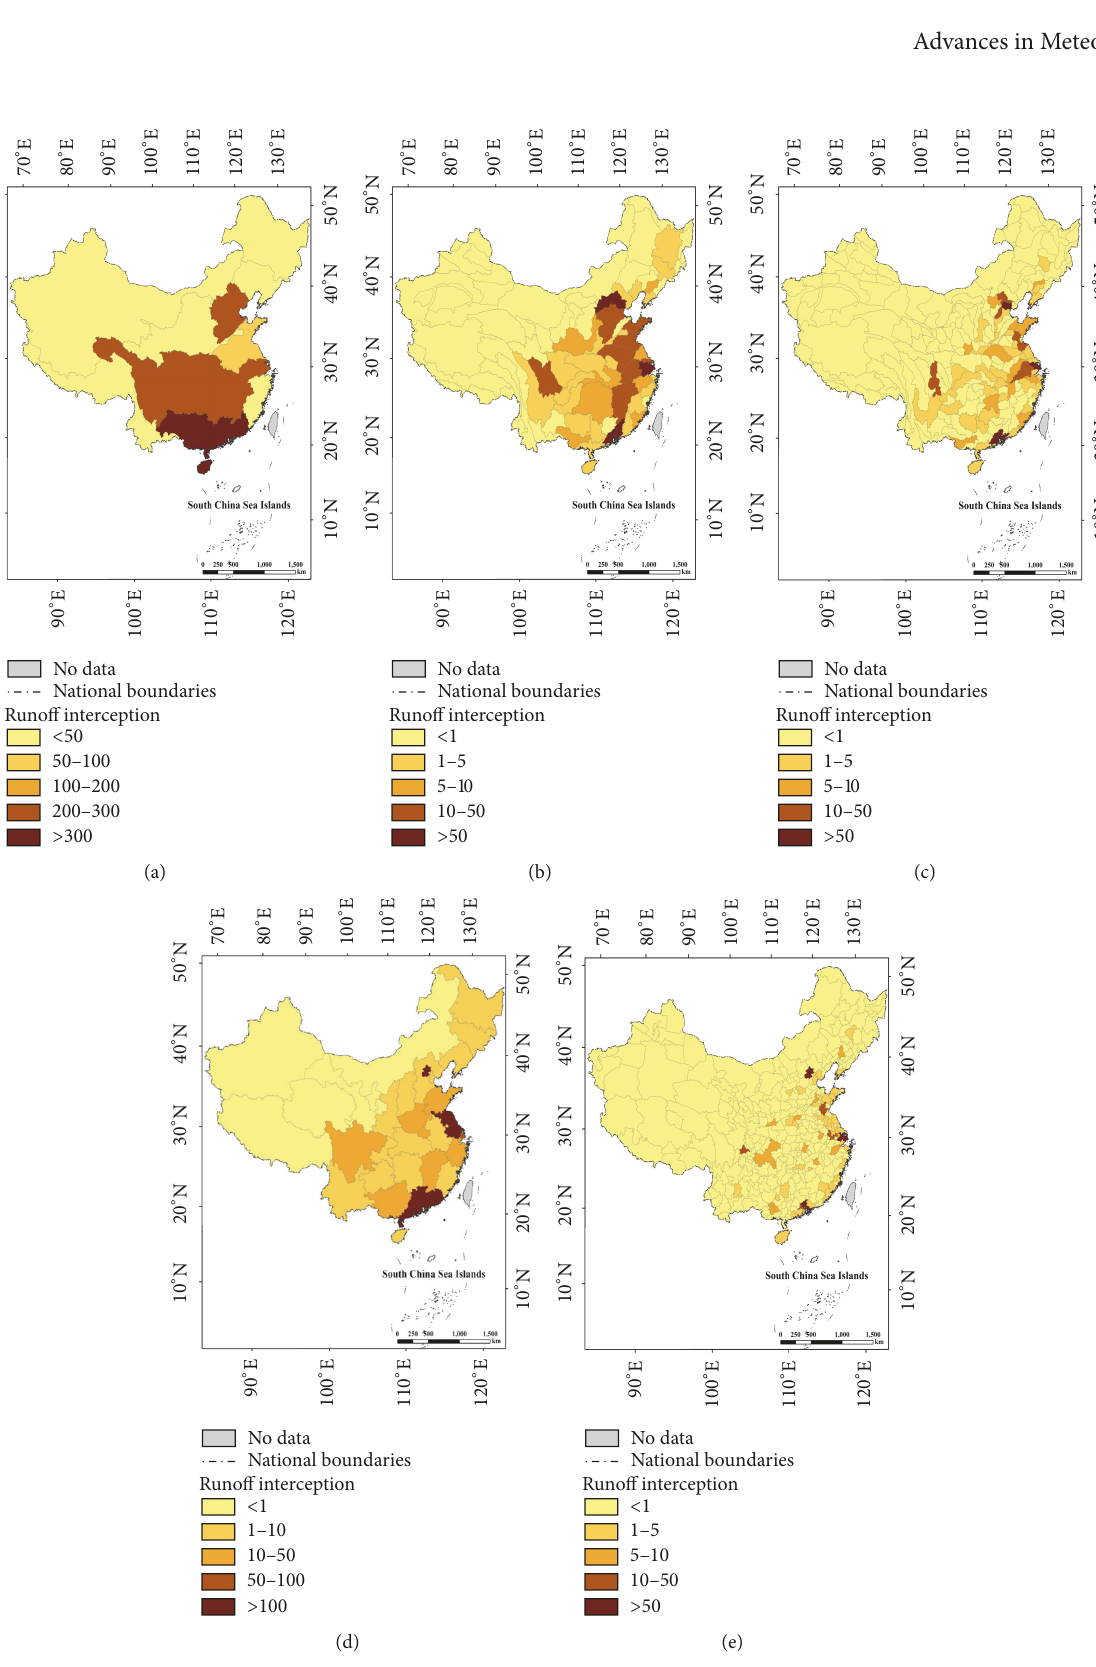
Figure 4: Annual runoff interception of five different zonal scale levels in China (unit: 10 8 m 3 ): (a) first-order zones of water resource, (b) second-order zones of water resource, (c) third-order zones of water resource, (d) province zones, and (e) city